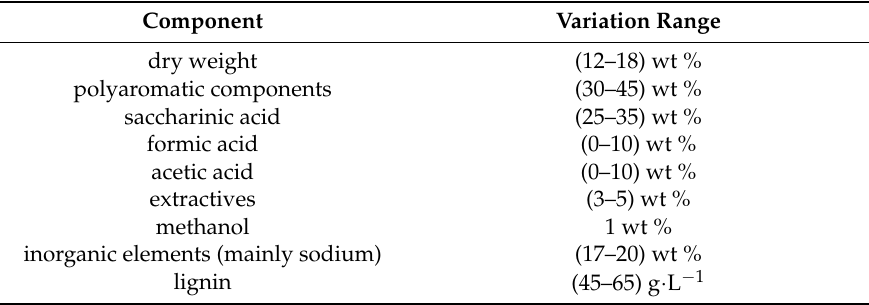
Table 1. Typical composition of black liquor [8].